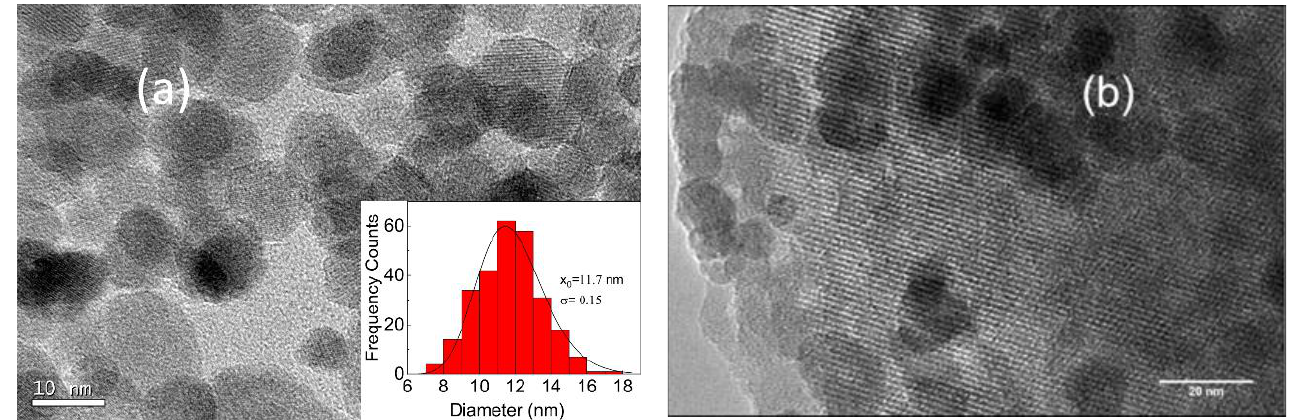
Figure 1. TEM of ( a ) γ-Fe 2 O 3 nanoparticles with the corresponding histogram and ( b ) γ-Fe 2 O 3 /H-USY(40).